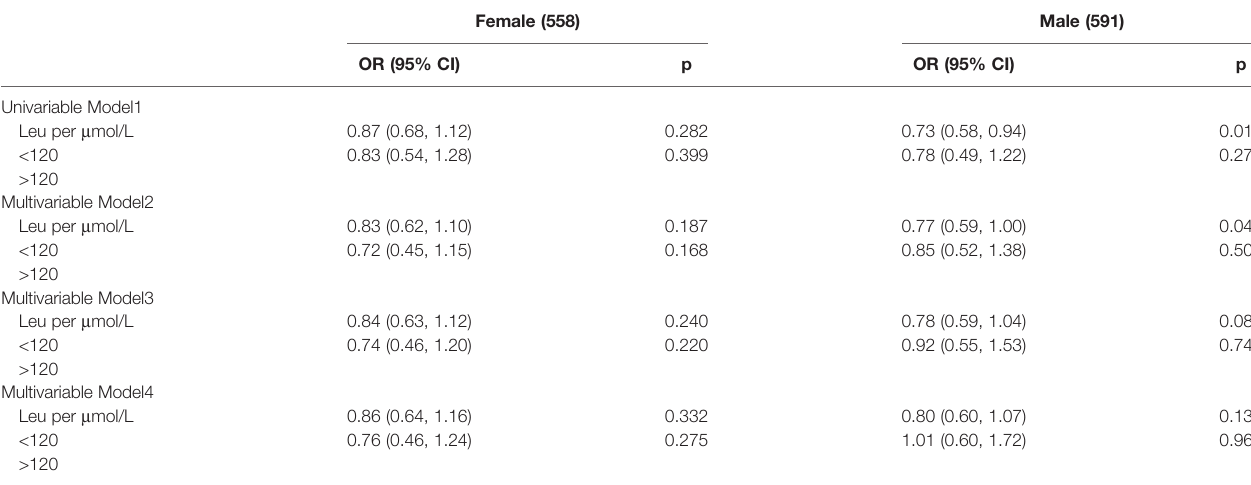
TABLE 3 | OR of leu and DR under multiple models of different